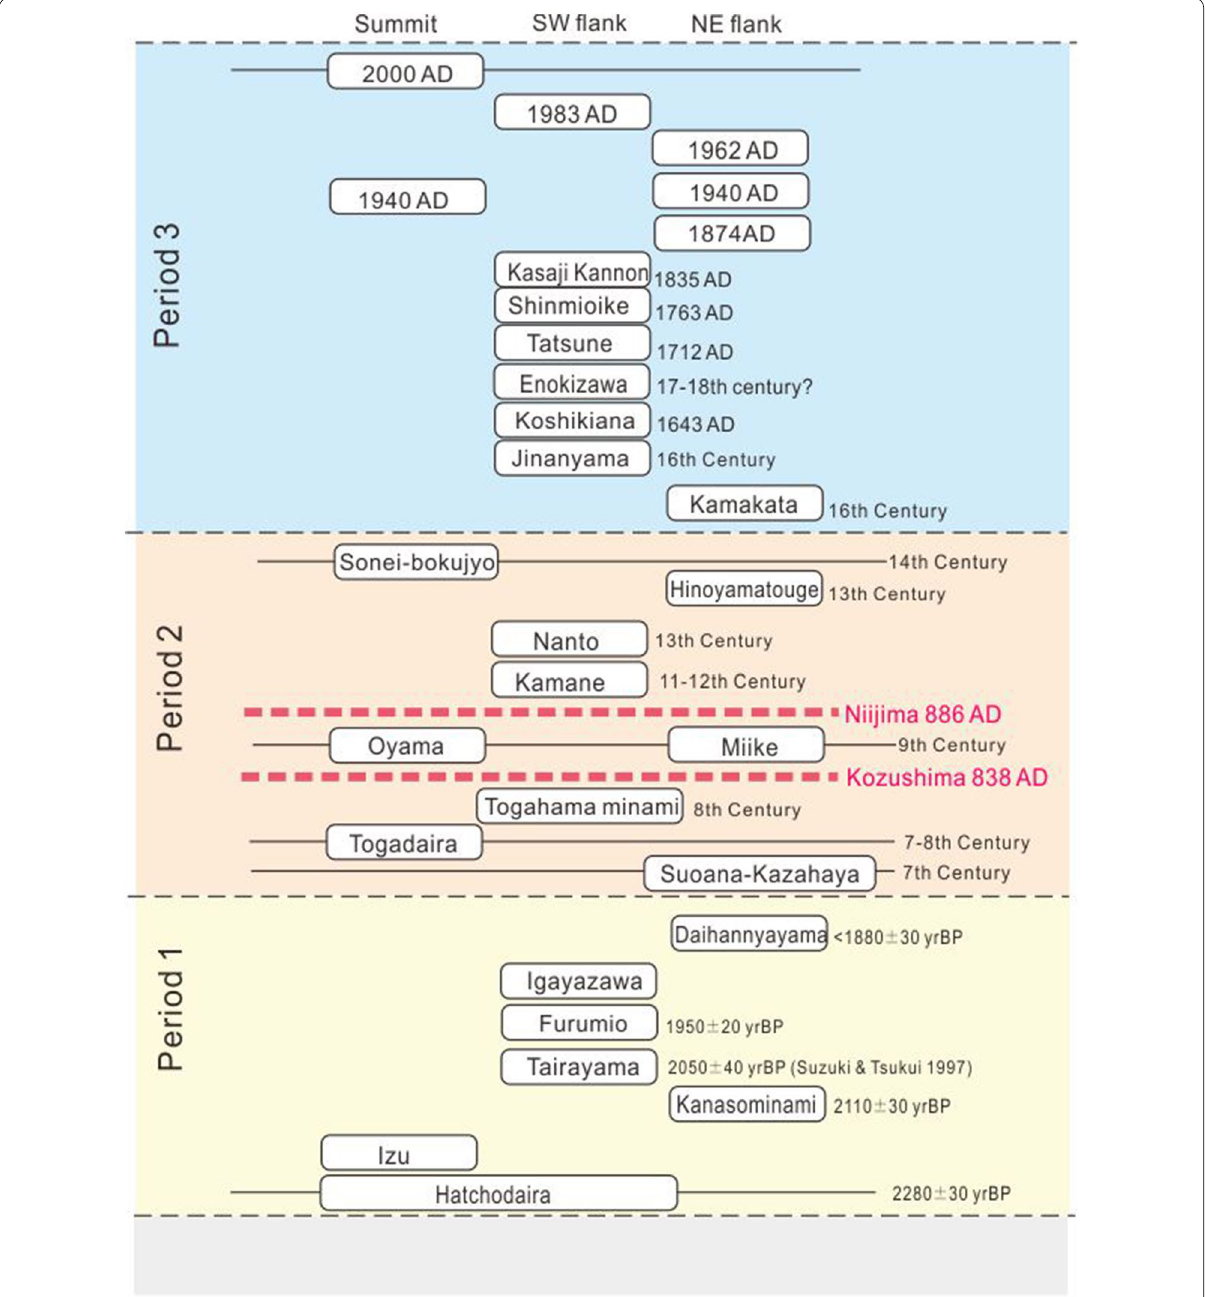
Fig. 2 Schematic stratigraphic relationship of the eruptions during periods 1, 2 and 3. Horizontal solid lines show the key tephra beds which cover the entire island. Note that there are several eruption products that have unfixed (approximated) stratigraphic positions particularly during Period 1 and 2